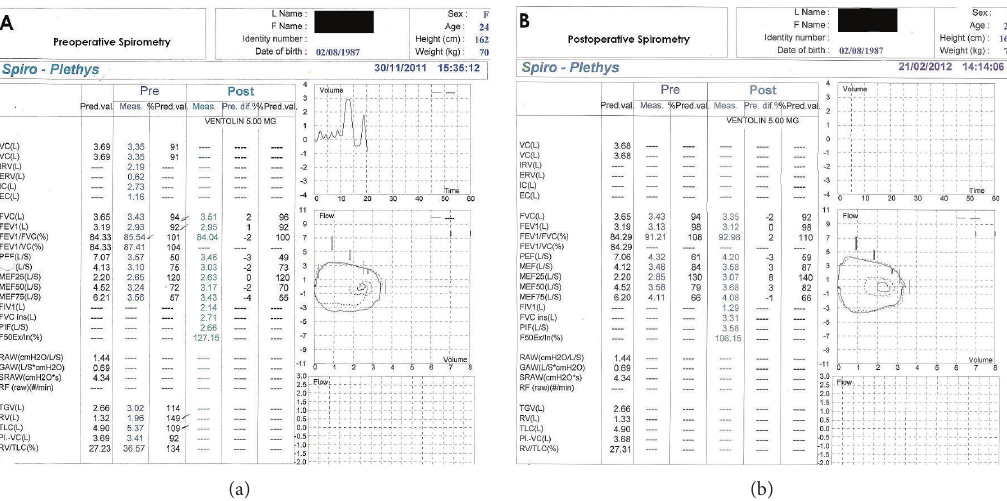
Figure 2: (a) Preoperative flow-volume loop demonstrating flattening of the inspiratory and expiratory segments (b) Flow-volume loop, after 8 weeks of surgery, showing slightly improved inspiratory and expiratory